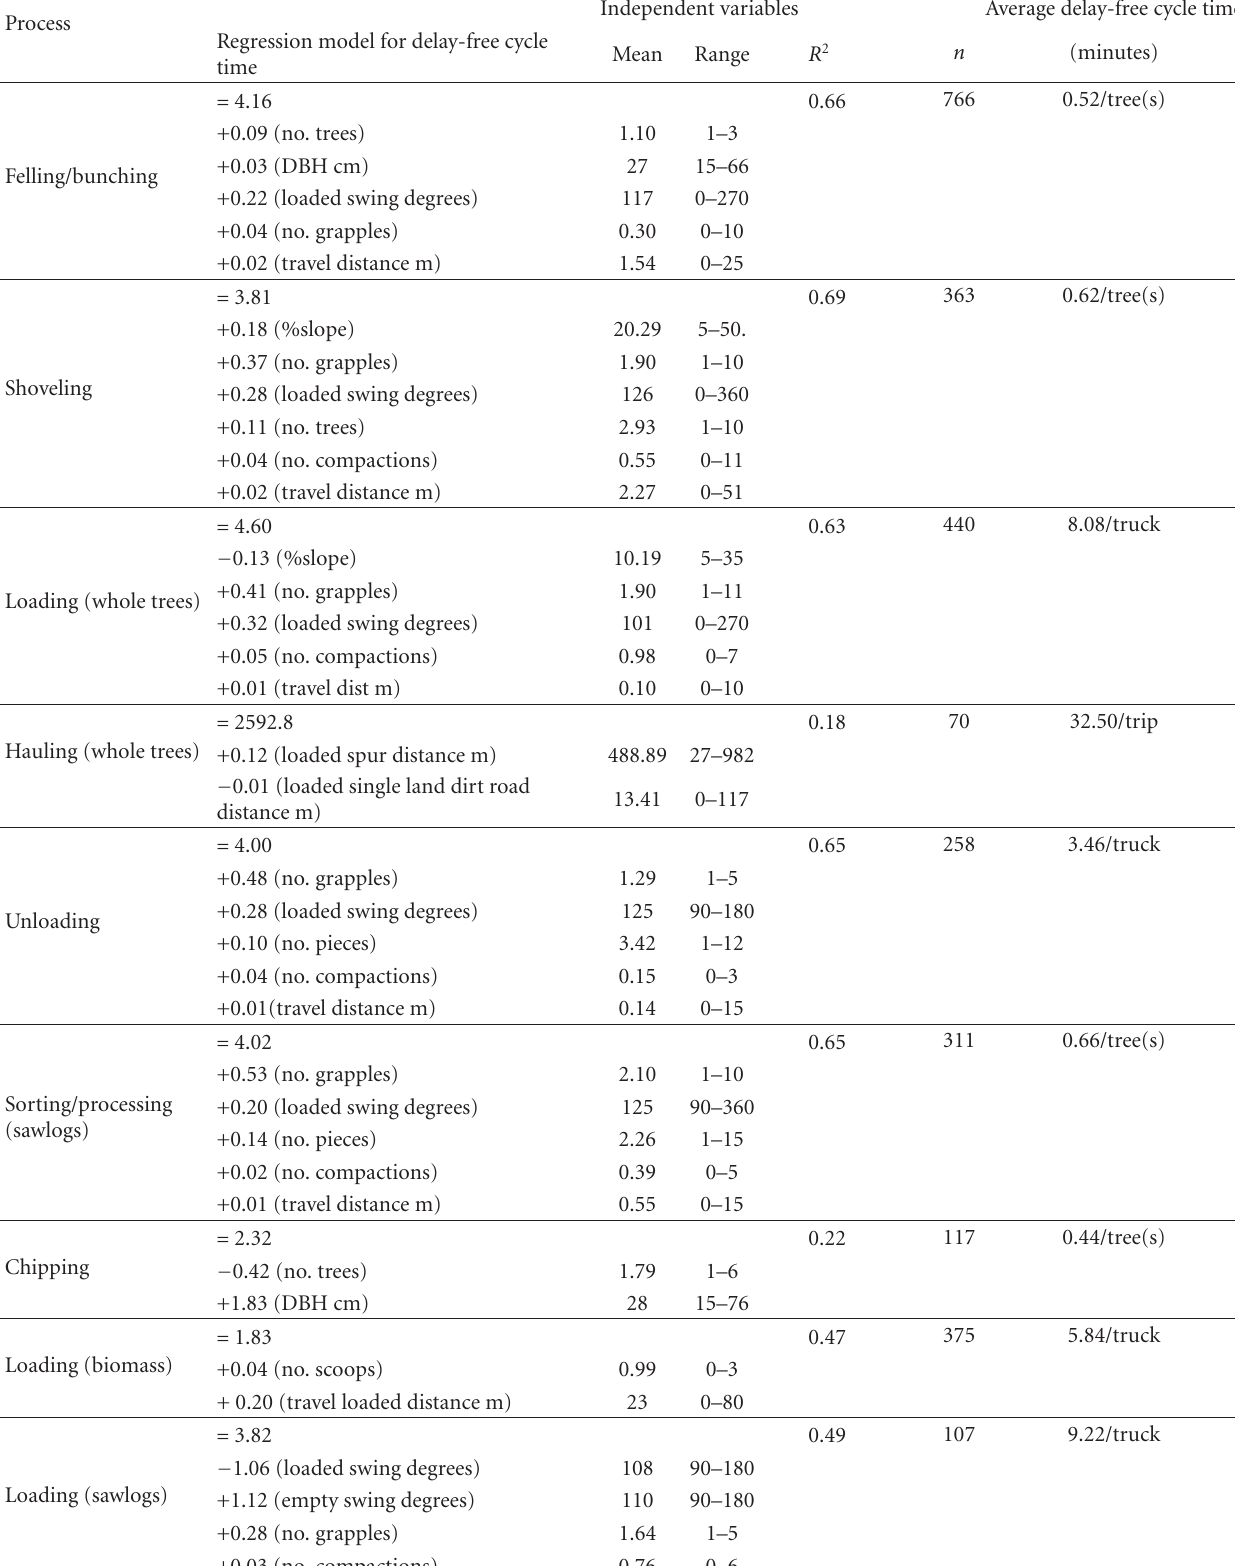
Table 2: Regression equations that describe predicted delay-free cycle times in minutes for the integrated harvesting system.